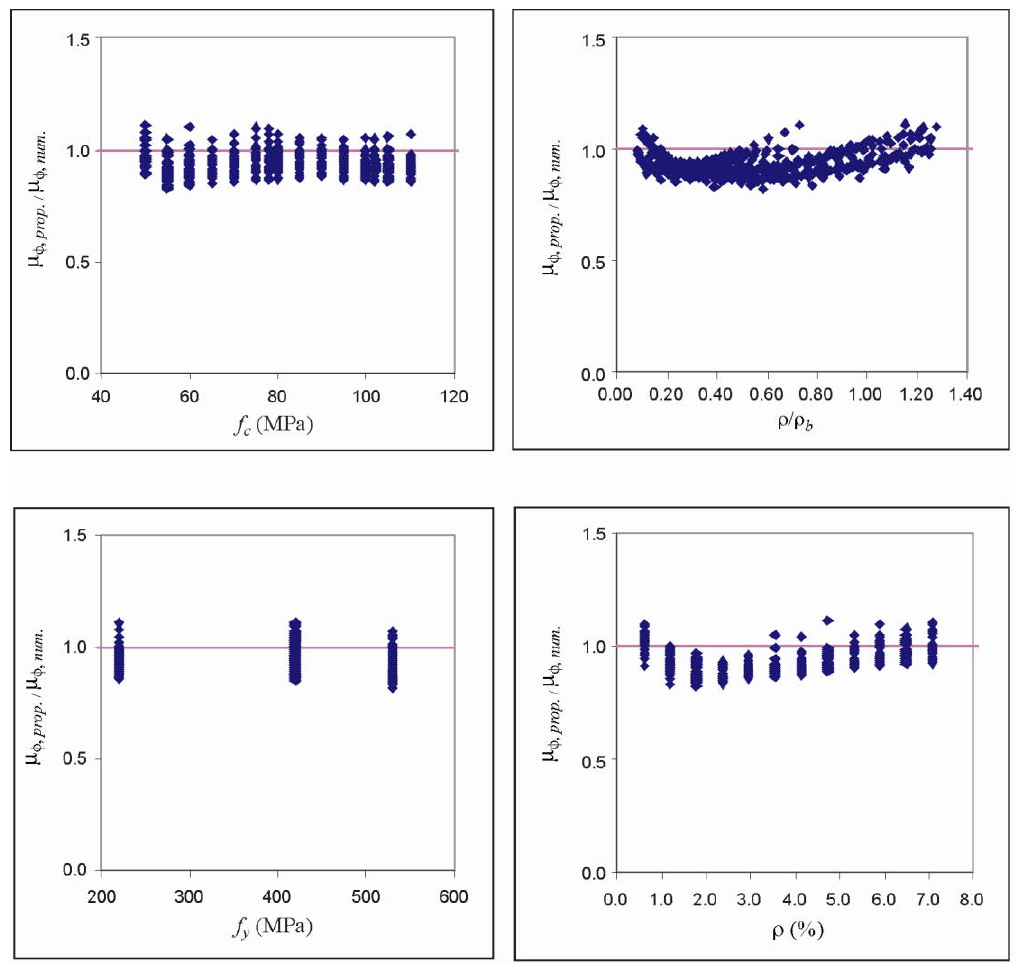
Fig. 6. Comparing curvature ductility on proposed Eq. (21) with numerical analysis results for various c f , b  / , y f and 